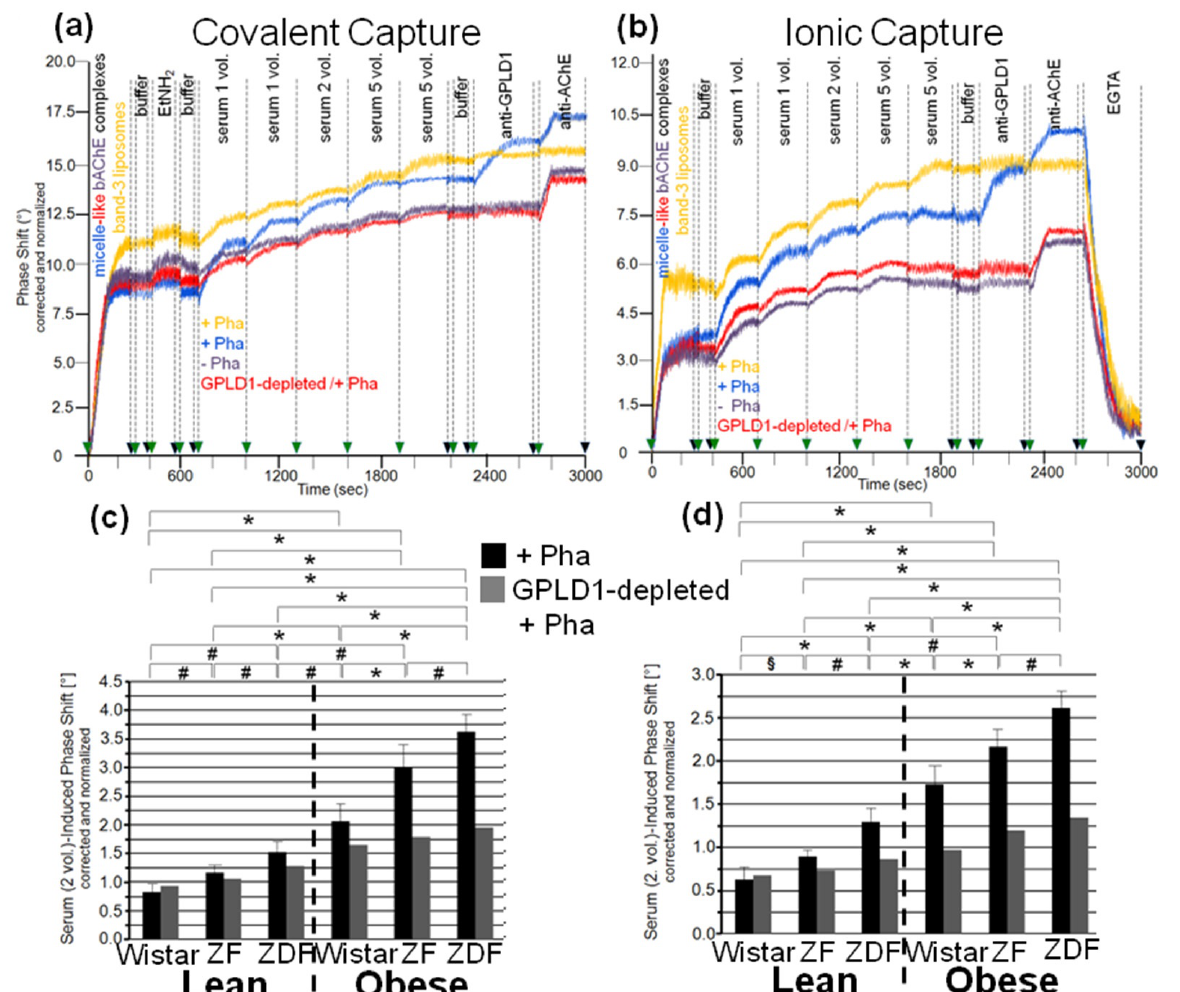
Figure 3. Measurement of the interaction of GPLD1 and other rat serum proteins with micelle-like bAChE complexes using covalent or ionic capture by the chips. Micelle-like bAChE complexes (blue, red, purple curves) or band-3 liposomes (orange curves), respectively, were covalently captured by chips upon injection into EDC/NHS-activated chips, washing with buffer, blockade of unreacted carboxyl groups by injection of EtNH 2 , and additional washing with buffer ( a , c ) or non-covalently captured by injection of Ca 2+ and subsequent washing with buffer ( b , d ). ( a , b ) Single or multiple 100 µ L portions (as indicated) of serum from obese ZDF rats, which had been depleted of GPLD1 by immune adsorption (red curves) or remained untreated (blue, purple, orange curves), were injected successively in the absence (purple curves) or presence (blue, red, orange curves) of Pha (0.5 mM). Following washing with buffer, anti-GPLD1 and anti-AChE antibodies were injected in sequential fashion. Finally, as a test for capture of the micelle-like bAChE complexes via Ca 2+ bridges, EGTA (5 mM) was injected (shown only for b ). The experiment was repeated once (distinct chip) with similar results (representatives shown). The measured phase shift is given upon correction for unspecific interaction with phospholipids (use of micelle-like complexes lacking protein) and altered viscosity (vs. buffer) of the sample fluids and normalization for the varying responsiveness of distinct chips toward GPI-AP capture. ( c , d ) Two 100 µ L portions each of untreated and GPLD1-depleted serum were injected. The serum-induced phase shift was calculated as the difference between time points 700/400 s (end of capture and washing) and 1300/1000 s (end of serum injection) for both covalent ( c ) and ionic ( d ) capture, and is given for the Pha-treated ( n = 8; means ± SD, quadruplicate measurements, black bars) and GPLD1-depleted as well as Pha-treated ( n = 1; duplicate measurements, grey bars) sera. The comparison of the serum-induced phase shift between the six rat groups is shown for the Pha-treated samples (black bars) only (* p ≤ 0.01, # p ≤ 0.02, § p ≤ 0.05). With both capture modes, the omission of Pha during the injections (purple curves) or the use of GPLD1-depleted serum (red curves) caused reductions in the serum-induced phase-shift increments by 30 to 40% (Figure 3a,b). Successful removal of GPLD1 from se- rum was confirmed by failure of anti-GPLD1 antibody to elicit further phase-shift increase (red curves), at variance with native serum (blue curves). Moreover, the anti-GPLD1 an- tibody failed to induce phase-shift increase with band-3 liposomes, compatible with fail- ure of GPLD1 to interact with liposomal phospholipids (orange curves). Importantly, very similar results were obtained with serum from control probands (Table 2) and the use of both covalent (Figure 4a) and ionic (Figure 4b) capture of the micelle-like bAChE complexes.